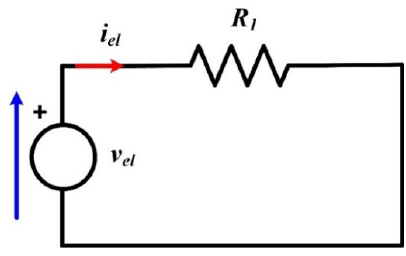
Figure 11. Equivalent electric model by using a resistor.